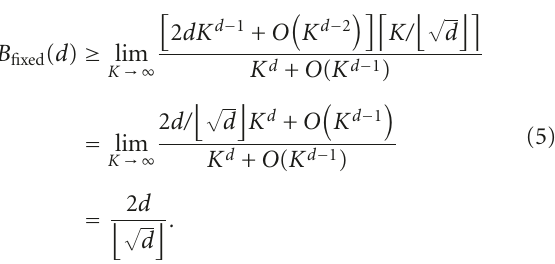
Figure 2: Configuration for which E routing / E coding = 3 is achievable. Nodes are a subset of the hexagonal lattice, with connectivity as depicted in (a). Unicast sessions are placed according to